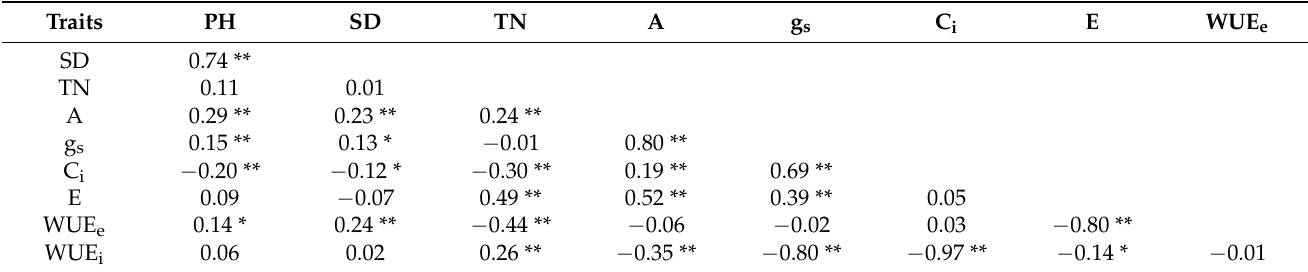
Table 2. The correlation analysis between growth traits and photosynthetic parameters based on the 2013 growing season. ** p < 0.01, * p < 0.05. PH: plant height; SD: stem diameter; TN: tiller number; A: photosynthetic rate; E: transpiration rate; g s : stomatal conductance; C i : intercellular CO 2 concentration; WUE e : extrinsic water use efficiency; WUE i : intrinsic water use